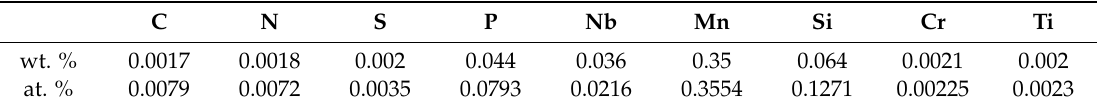
Table 1. Chemical Composition of IF steel.